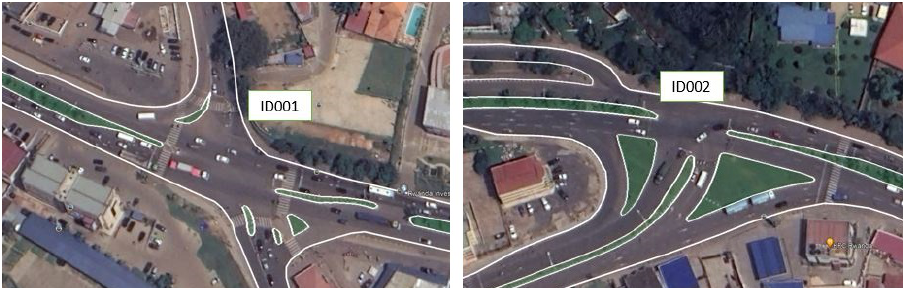
Figure 1. Two consecutive junctions at Remera.